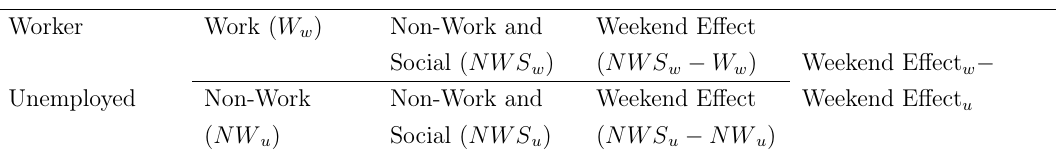
Figure 1: Time use by day of week for workers and the